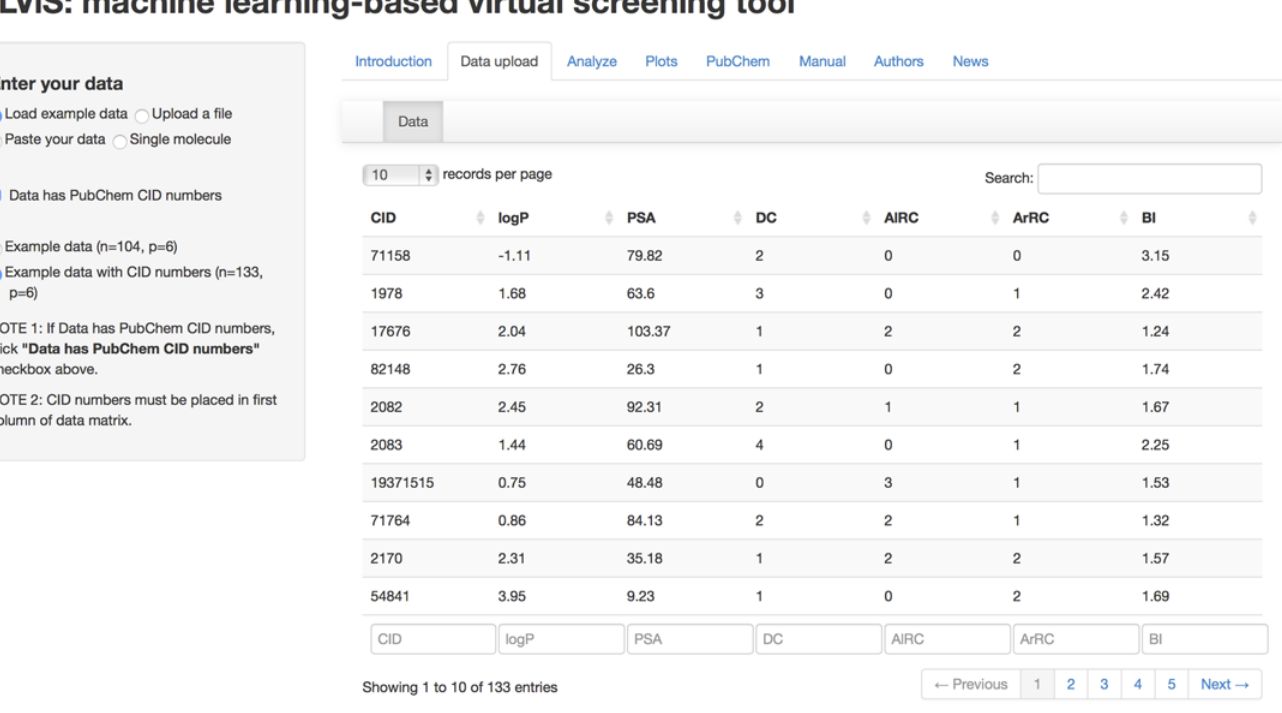
Fig 3. Data upload tab of the MLViS web-tool. Users can upload their files using upload file, paste data or single molecule options.